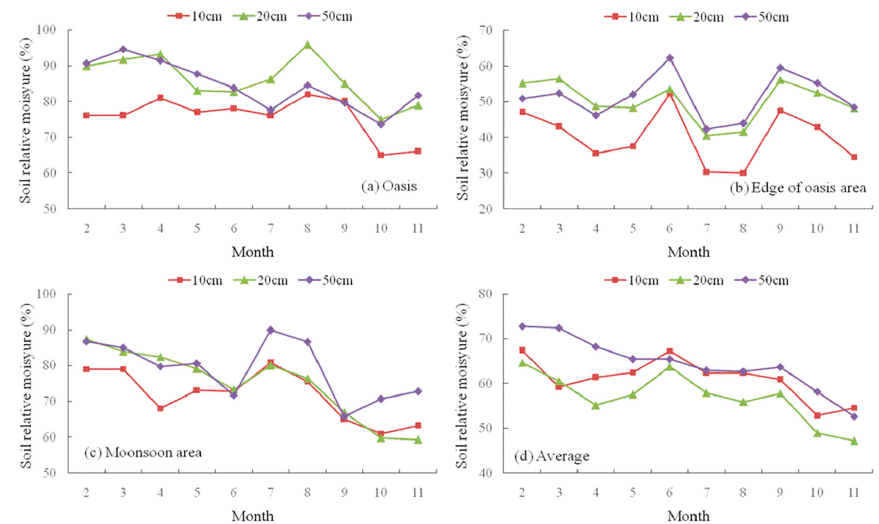
Figure 5. Seasonal variation of the relative soil moisture of farmland in the arid inland river basin areas.